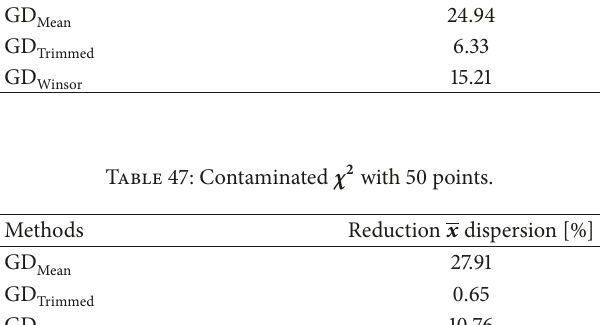
. On the right end side, the zoomed projections on the 𝑠 GDGM corresponds exactly to the 20% of additive Gaussian noise. mean